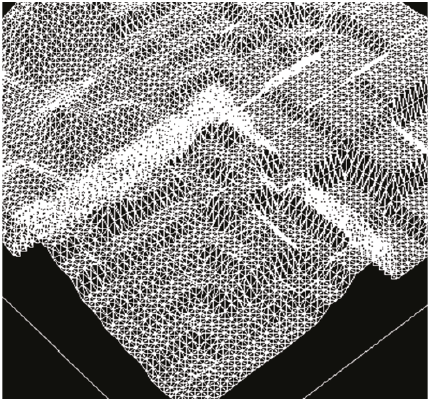
Figure 19: 3D triangulation of the replication example from Figure 15(b) ( l h = 0, l m = 2, l l =